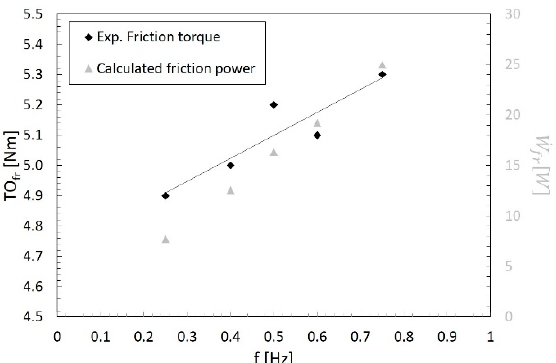
Figure 7. Experimental resistant torque by friction effects (left y-axis) and correlated power dissipated (right y -axis) for different operating frequency.